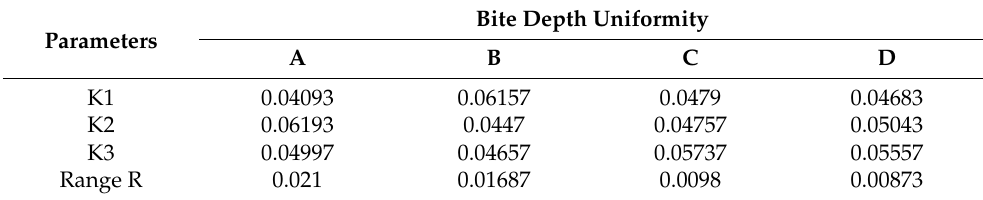
Table 7. Range analysis of bite depth uniformity.